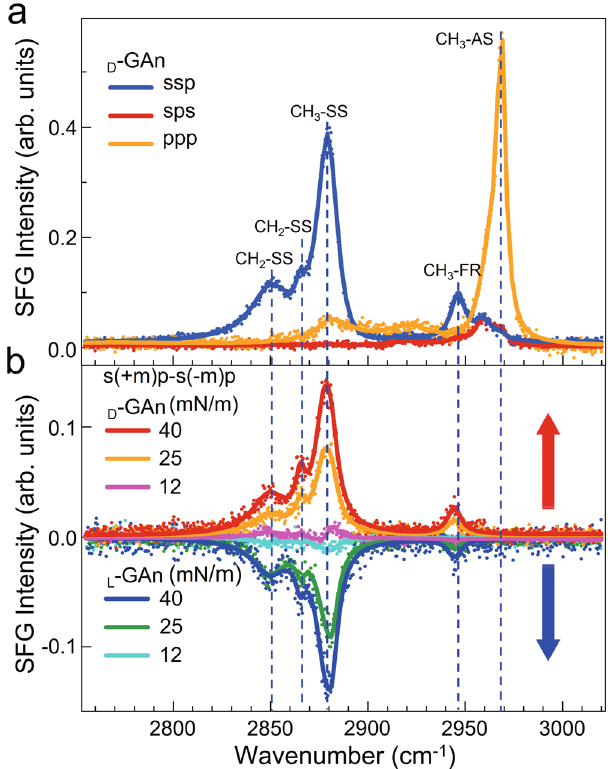
Fig. 2 | SFG spectra in the region corresponding to C – H stretching